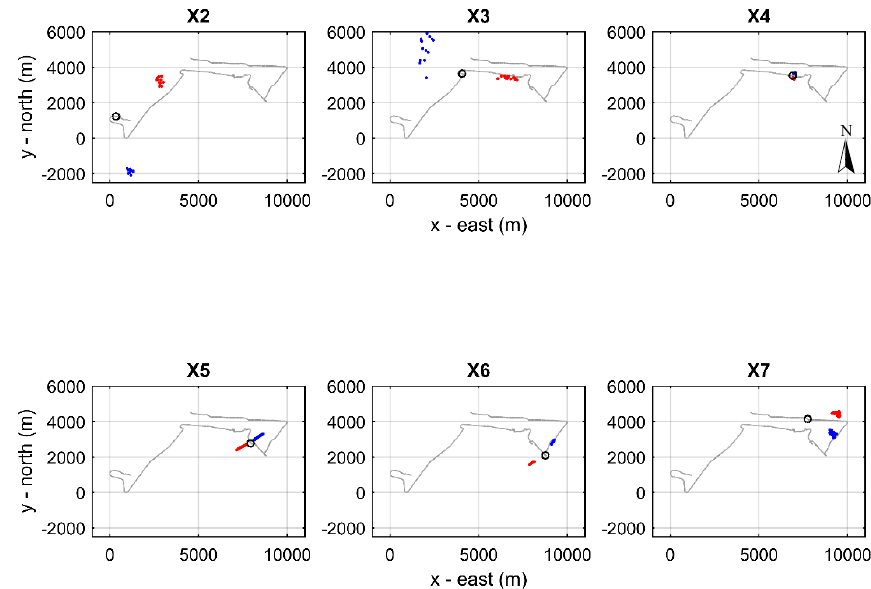
Figure 16. Estimated horizontal positions for sperm whale X during stations X2–X7; the two families of solutions are marked by dots of different color (blue and red). The vessel track and middle position during each station are marked by a light line and a circle, respectively.